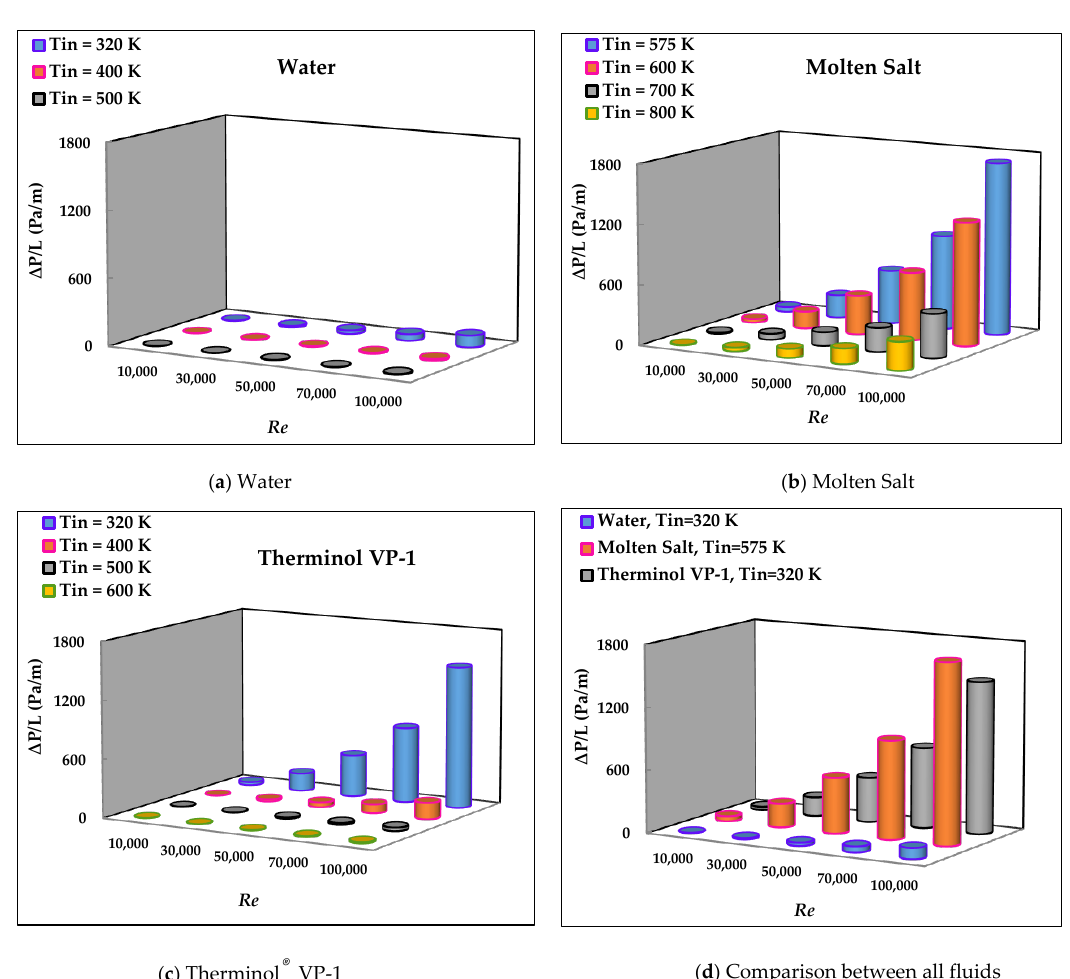
Figure 7. The specific pressure drop profiles of all fluids under consideration.